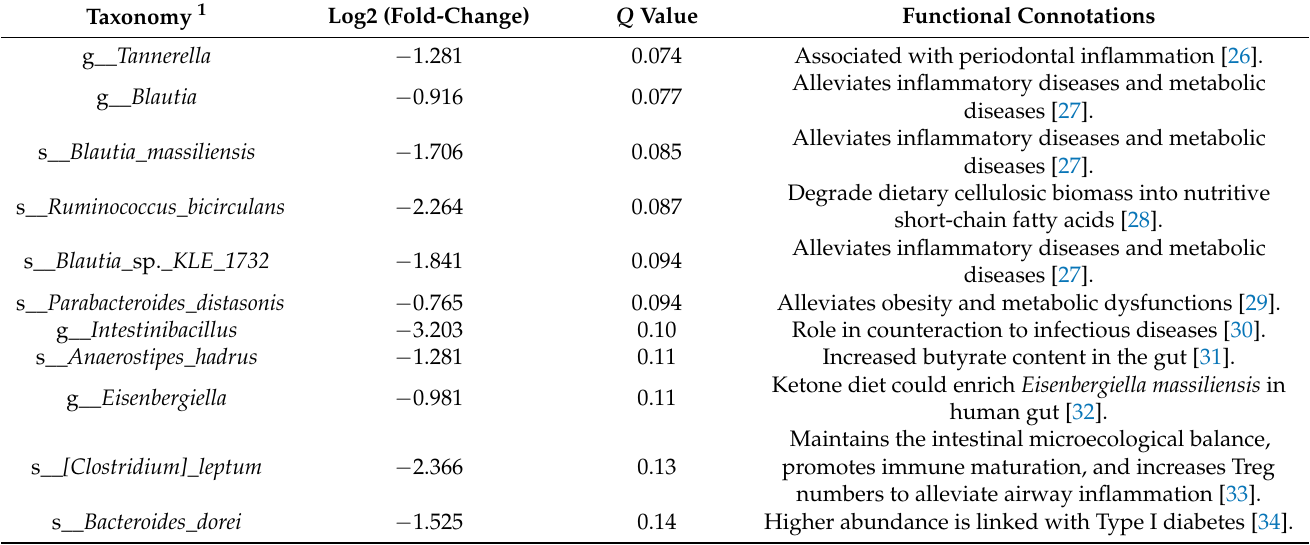
Table 3. Day 30 comparison of the taxonomic abundance of subjects demonstrating UV resistance following grape consumption ( n = 9) vs. subjects not resistant to UV irradiation following grape consumption ( n = 20).